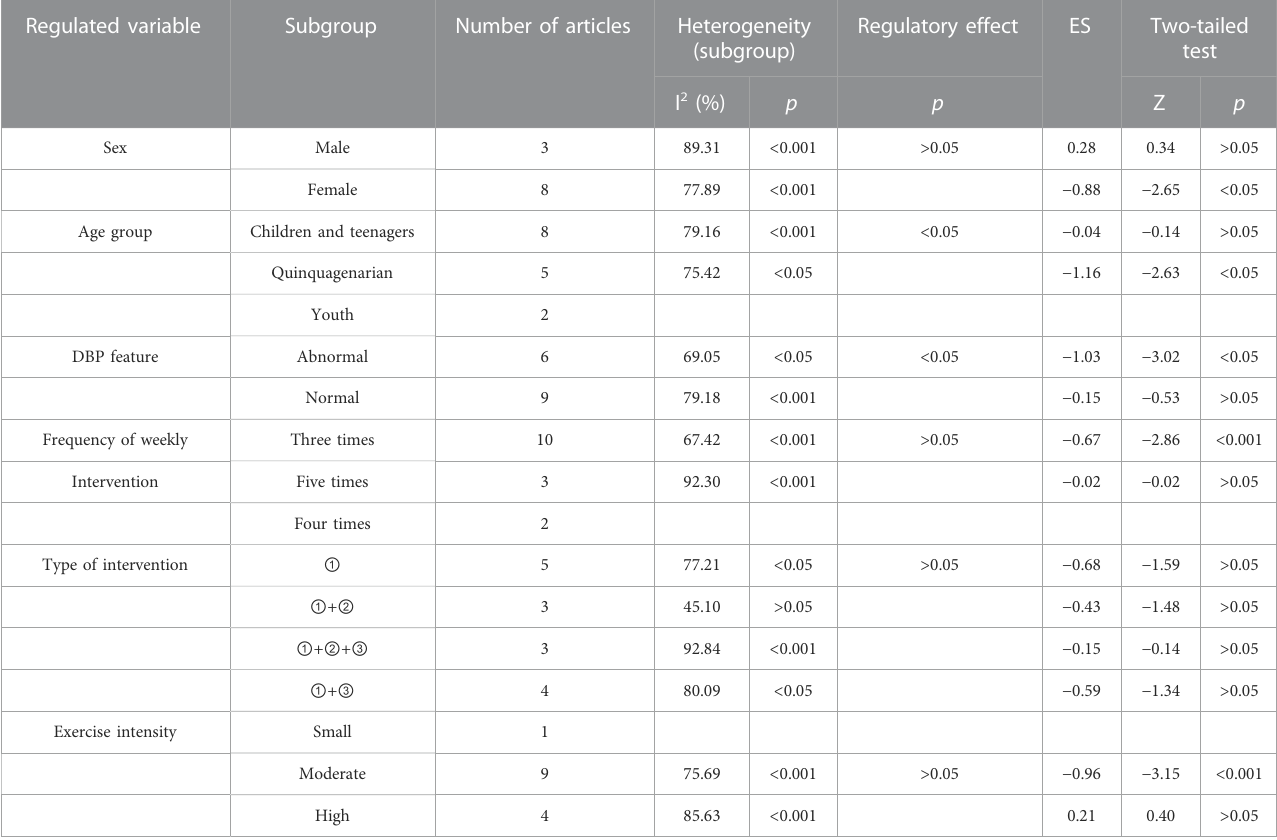
TABLE 6 DBP subgroup analysis. Regulated